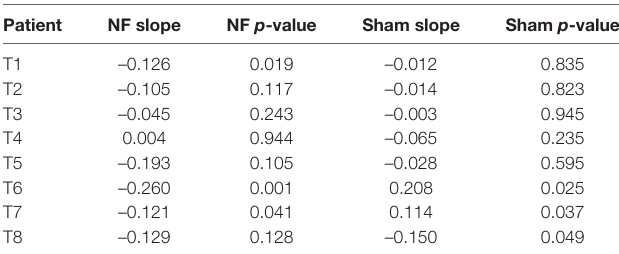
TABLE 2 | Results of the general linear modeling in individual cases for the tension-type headache